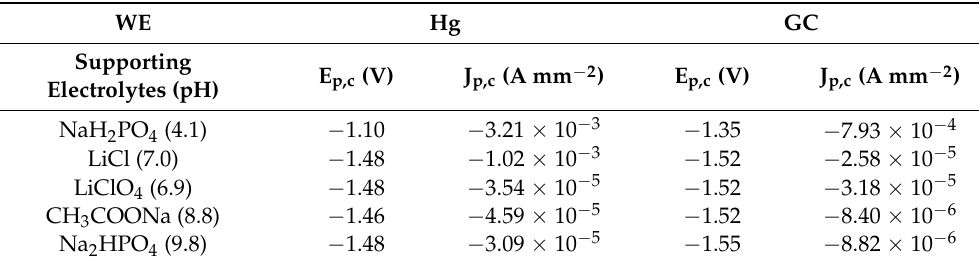
Table 2. Cathodic peak potential (E p,c ) and current density at the cathodic peak (J p,c ) of the irreversible reduction process of HMF by varying the nature of the WE (Hg or GC) and the nature and the pH of the solvent system (a 0.1 mol dm − 3 water solution of five different supporting electrolytes).